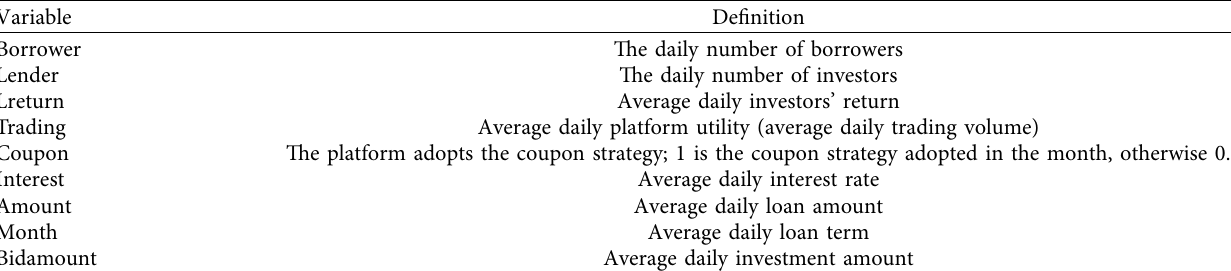
Table 6: Definition of